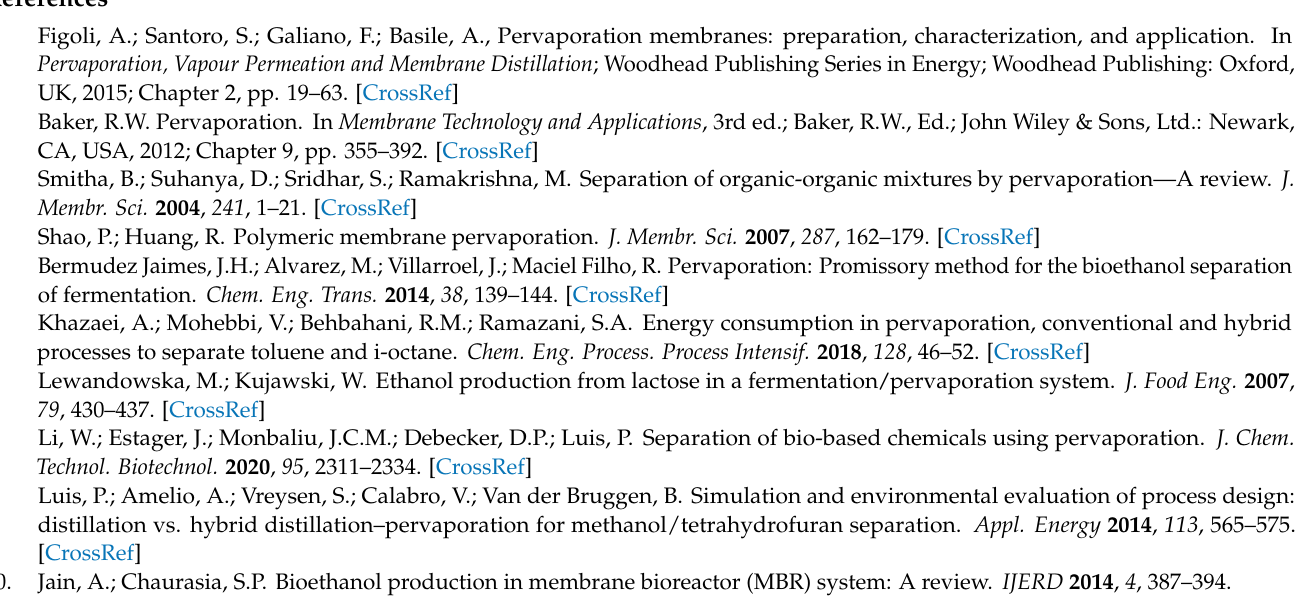
effective area: 178cm 2 , permeate pressure: 300Pa, Table